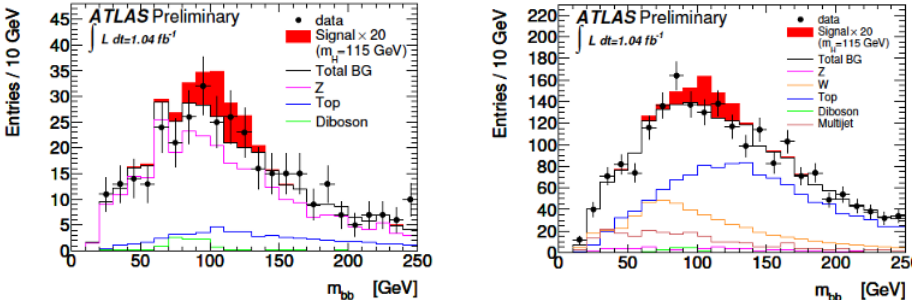
Fig. 1. The di- b -jet invariant mass for ZH → llb ¯ b (left) and WH → l ν b ¯ b (right) for m H = 115 GeV. The signal distribution is enhanced by a factor of 20 for visibility